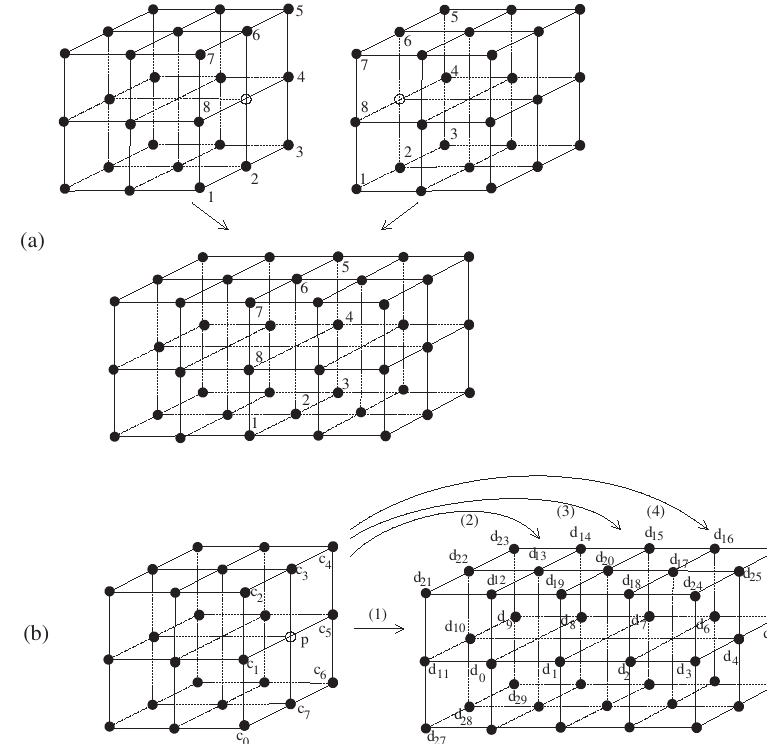
Figure 3. ( a ) Process of constructing MSS 6 (cid:93) MSS 6 [5]; ( b ) Configuration of C 3